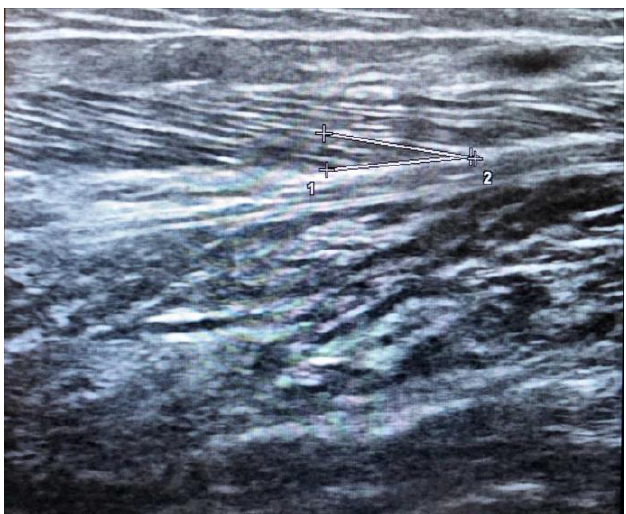
Figure 2. Ultrasound estimation of Pennation angle in the medial gastrocnemius given bu deep aponeurosis (1-2) and fascicle region (+).